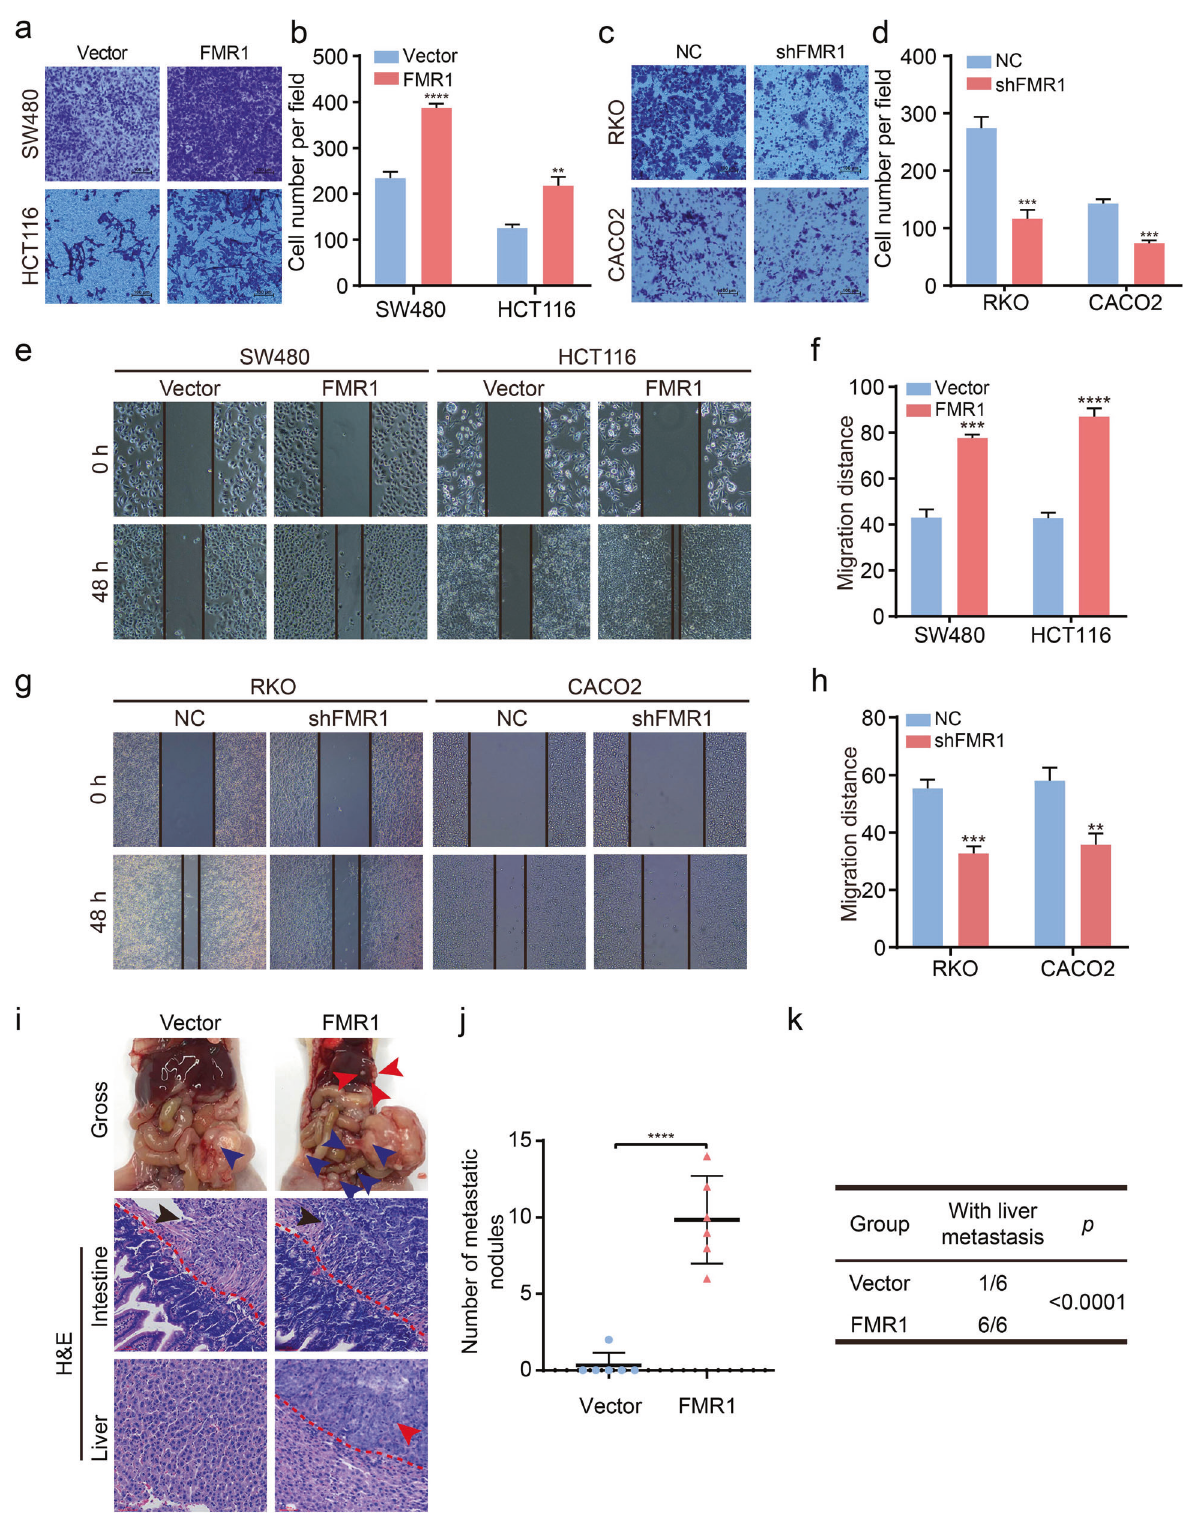
Fig. 3 FMR1 facilitates the metastasis of CRC cells in vitro and in vivo. a – d Representative results of transwell assays. The bar chart represents the migration cell numbers. Error bars represent the means ± SD of 3 different fi elds. e – h Representative results of wound healing assays. The bar chart represents the migration distance. Error bars represent the means ± SD of 3 different fi elds. i Representative gross images of the orthotopic mouse metastatic model from different experimental groups are shown. Sections of the liver were stained with H&E. j The statistical analysis of number of liver metastatic nodules. Error bars represent the means ± SD. k The statistical distribution of metastasis numbers. ** P < 0.01, *** P < 0.001, **** P < 0.0001.